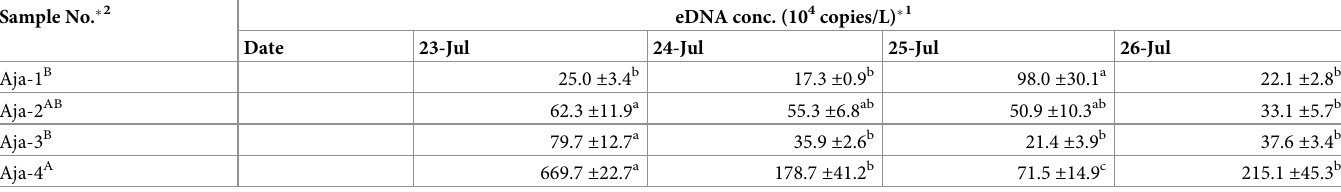
Table 2. Variation in eDNA concentration (eDNA conc.) during acclimatization. Sample No. � 2